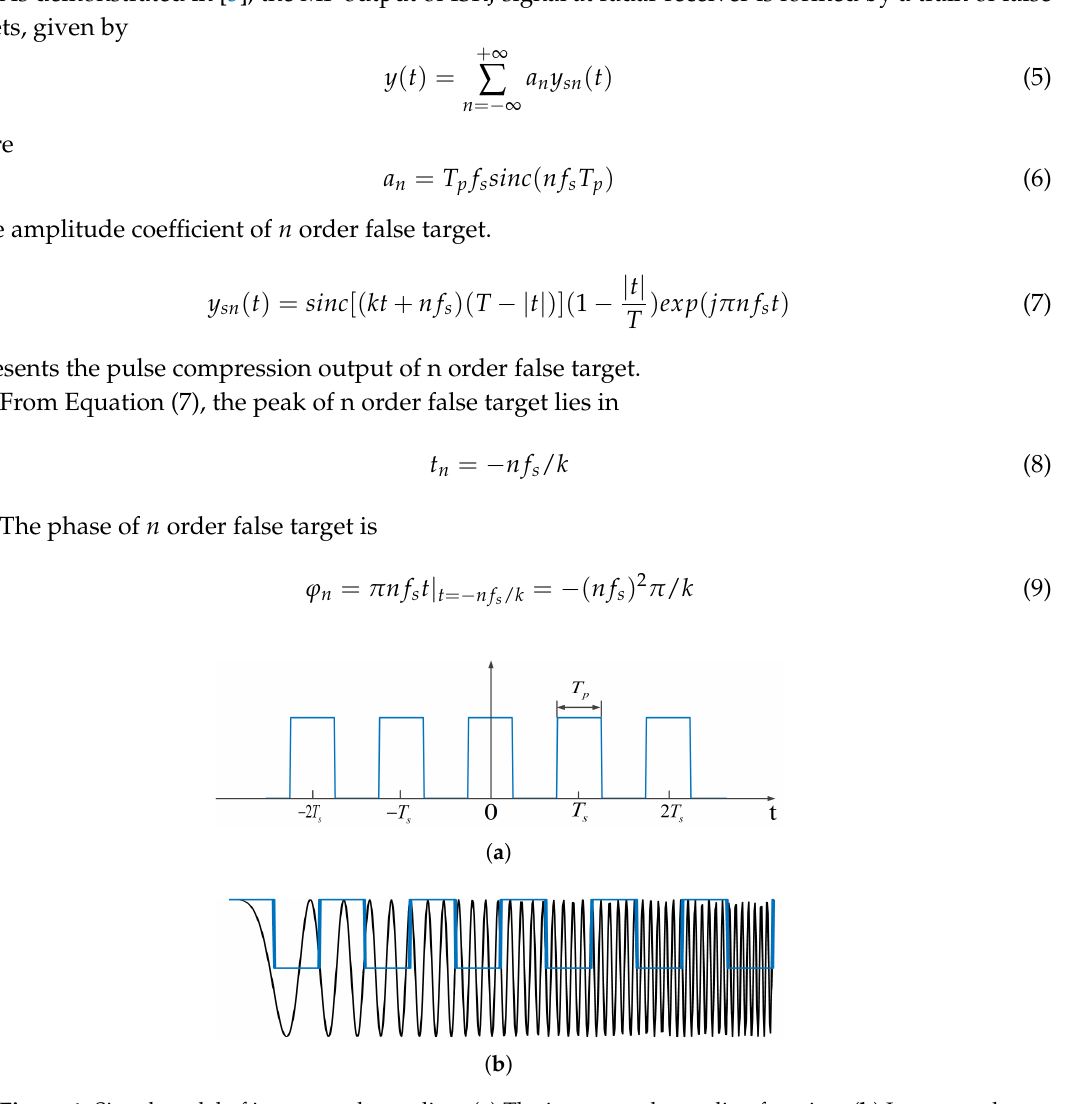
Figure 1. Signal model of interrupted sampling. ( a ) The interrupted sampling function. ( b ) Interrupted sampling of linear frequency modulation (LFM)